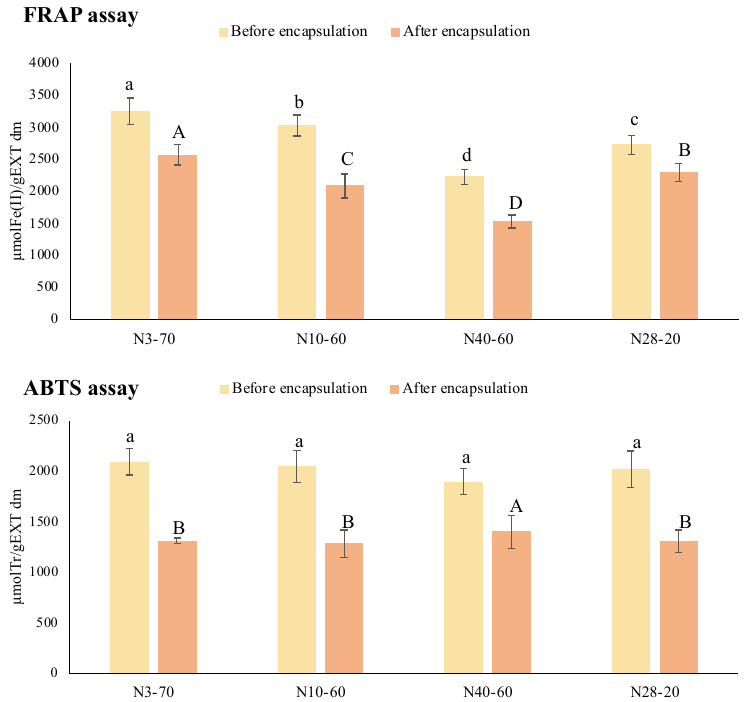
Figure 3. In vitro antioxidant capacity (evaluated with FRAP and ABTS assays) of extracts before (yellow) and after spray-drying (orange) with β -CD. Values reported on extract (EXT) dry matter (dm). Tr: Trolox. Error bars indicate ± standard deviation of mean values. Lowercase letters indicate comparisons between initial commercial extracts, while uppercase letters indicate comparisons between the encapsulated ones.